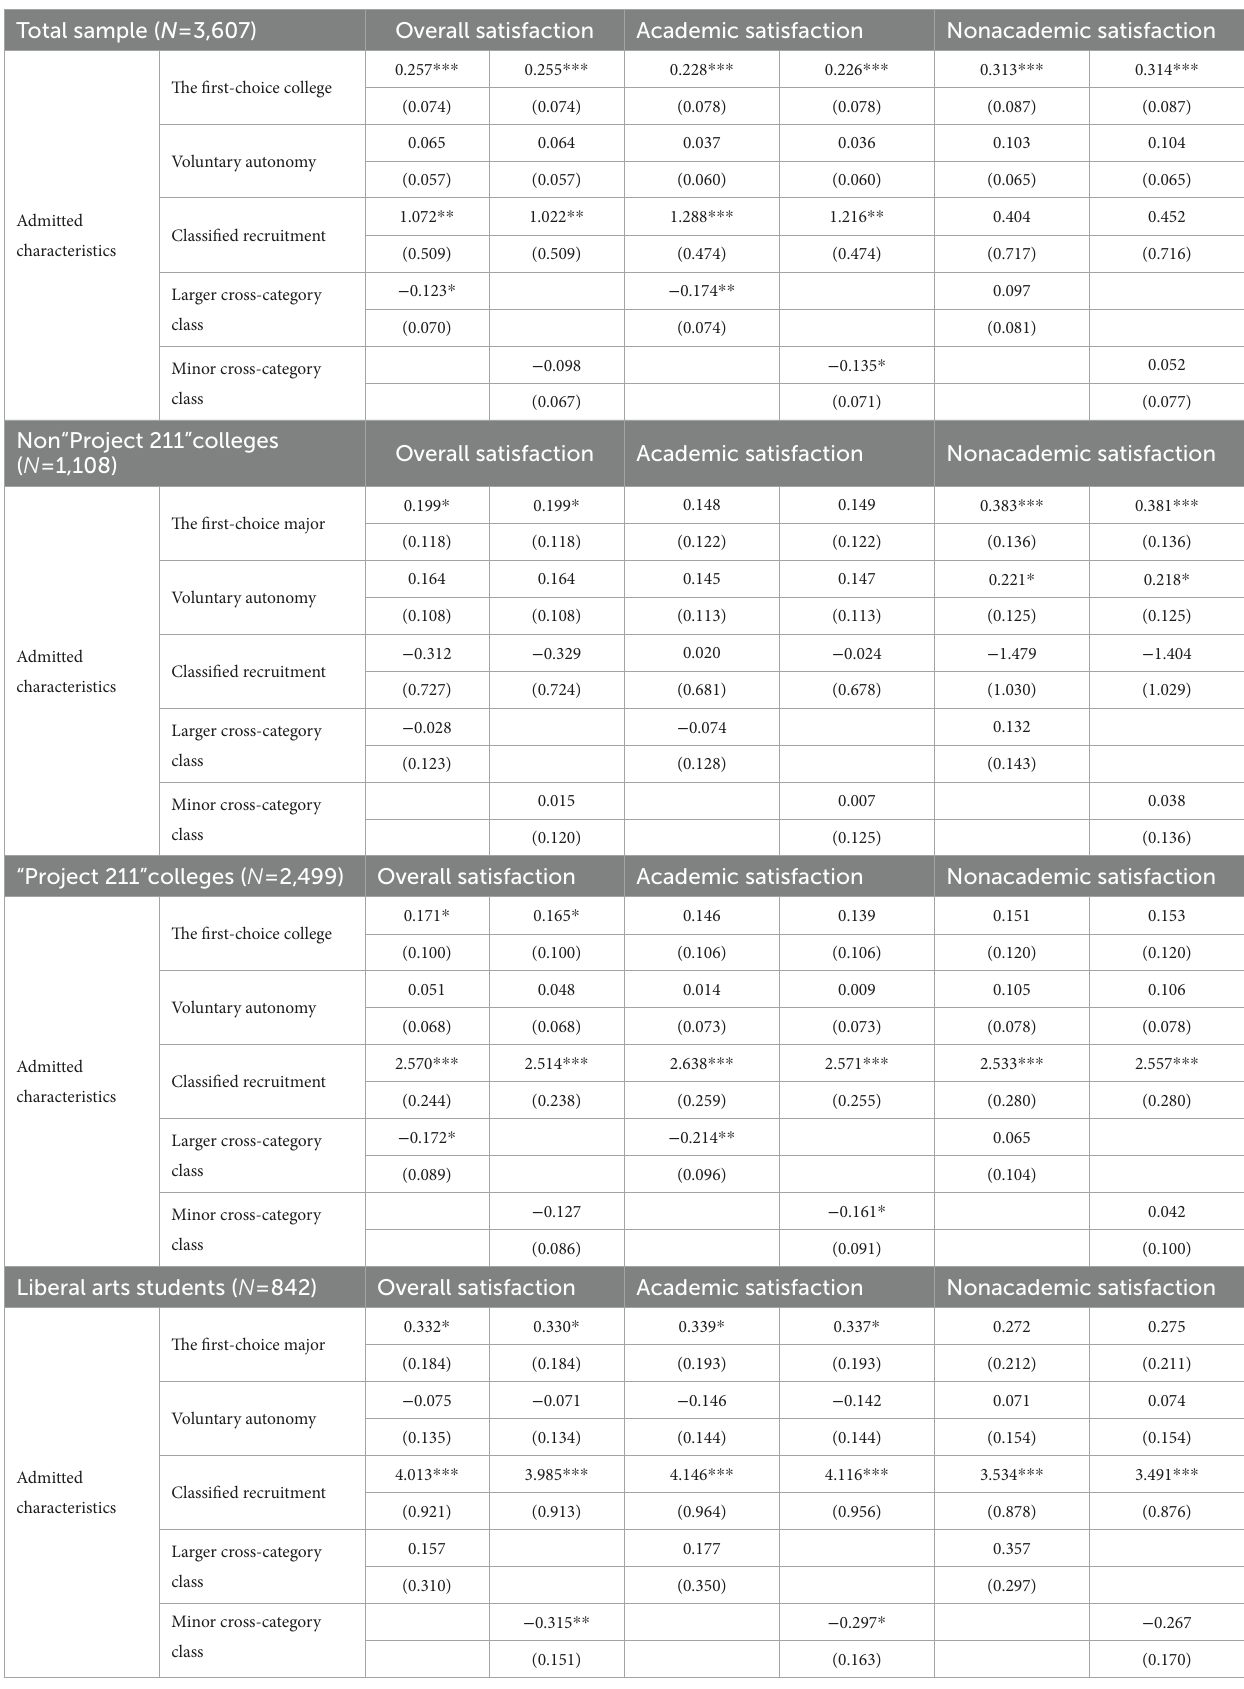
TABLE 8 Impacts of the characteristics of college entrance examinations on the satisfaction of students whose current majors are not their first choices. Total sample ( N =